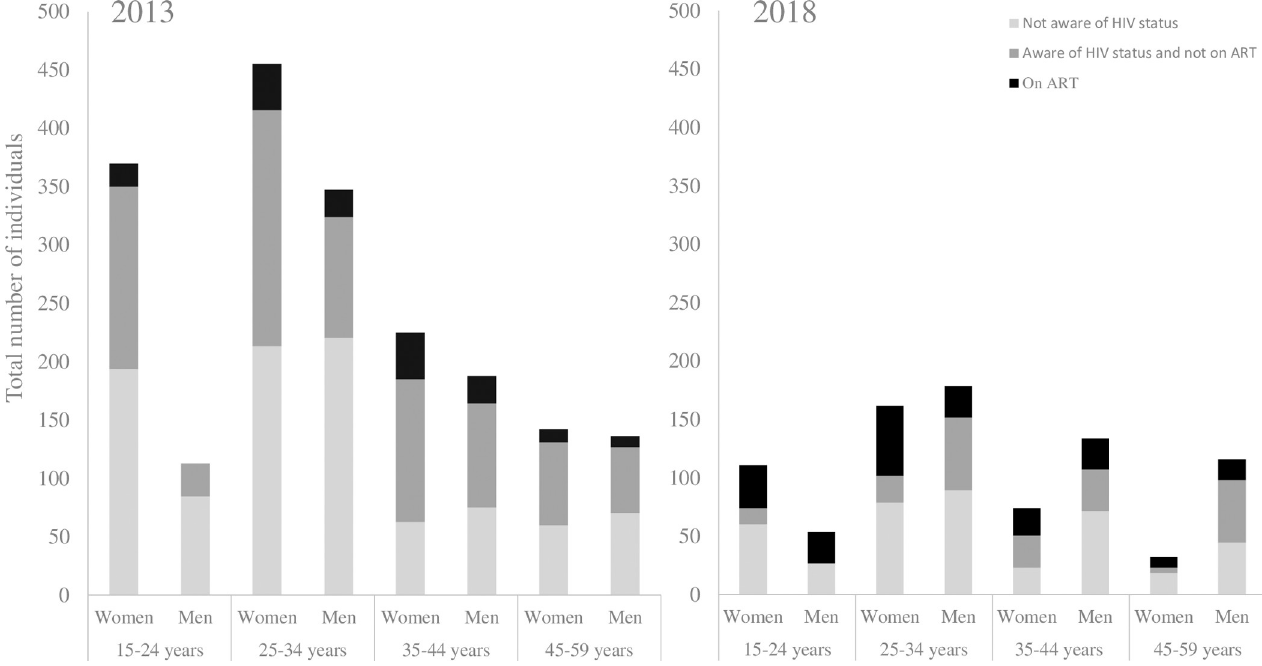
Fig 2. HIV-positive participants with viral load � 1,000 copies/mL, stratified by sex and age according to their HIV status awareness and antiretroviral treatment status, and adjusted to a surveyed population of 10,000 persons, KZN, South Africa, 2013 and 2018.